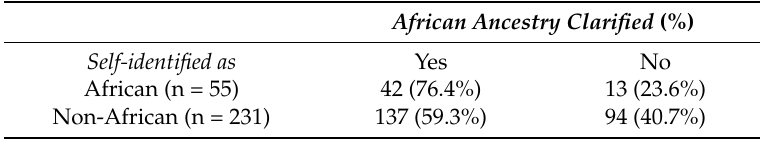
Table 1. Chi-square test and descriptive statistics for African ancestry clarified for people who identify as African vs. Non-African. African Ancestry Clarified (%) Self-identified as Yes No African (n = 55) 42 (76.4%) 13 (23.6%) Non-African (n = 231) 137 (59.3%) 94 (40.7%)